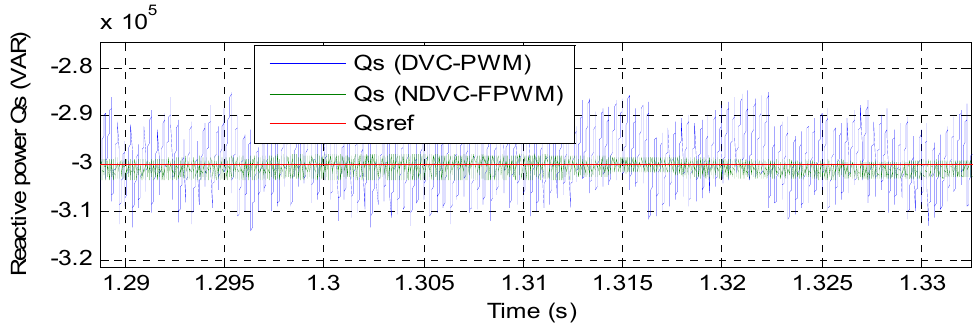
Figure 21. Zoom in the Qs .